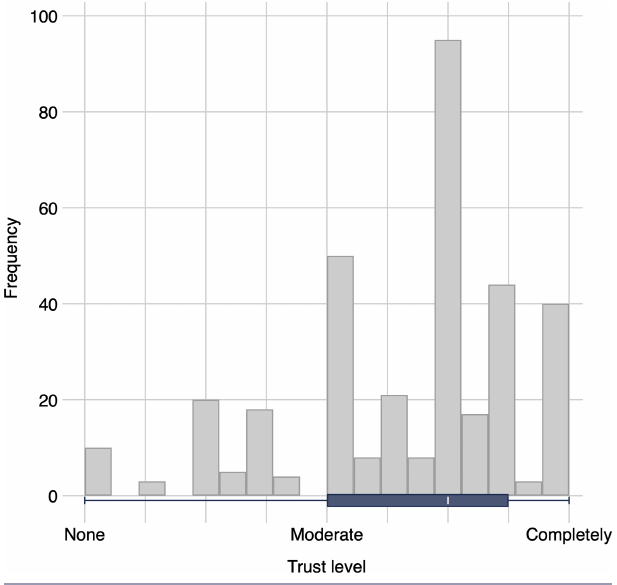
Fig. 2 . Histogram with boxplot showing the distribution of overall trust in a water utility to provide safe drinking water.